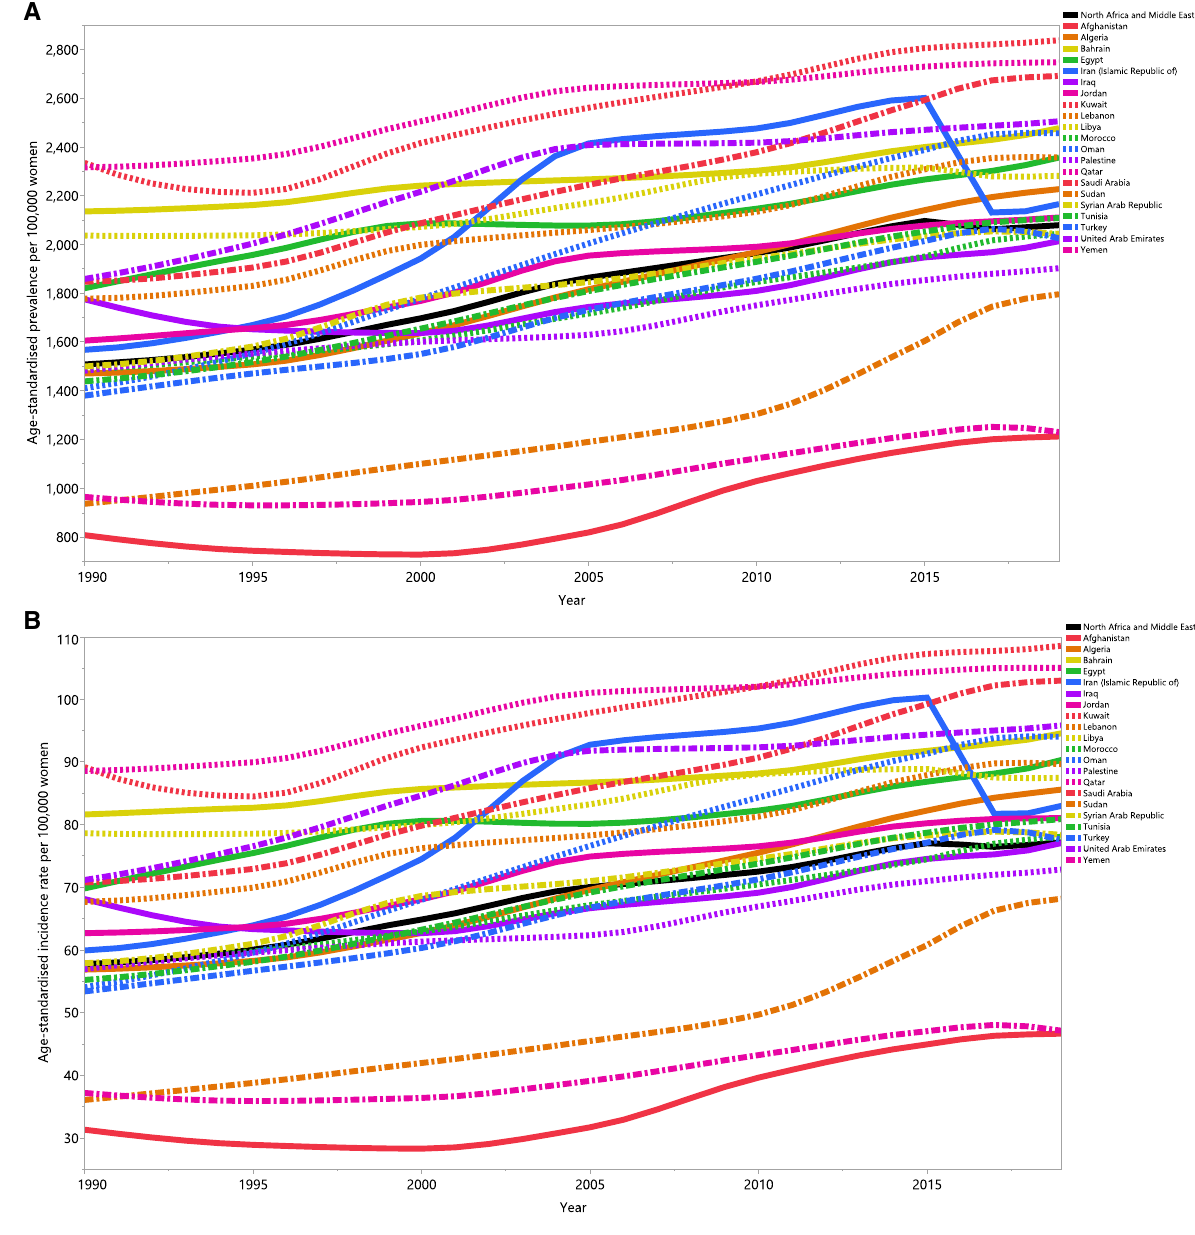
Figure 1. Age-standardised point prevalence ( A ), incidence ( B ), and YLDs ( C ) for polycystic ovary syndrome (per 100,000 population) in the Middle East and North Africa region from 1990 to 2019, by country. YLD = years lived with disability. (Generated from data available from http:// ghdx. healt hdata. org/ gbd- resul ts-